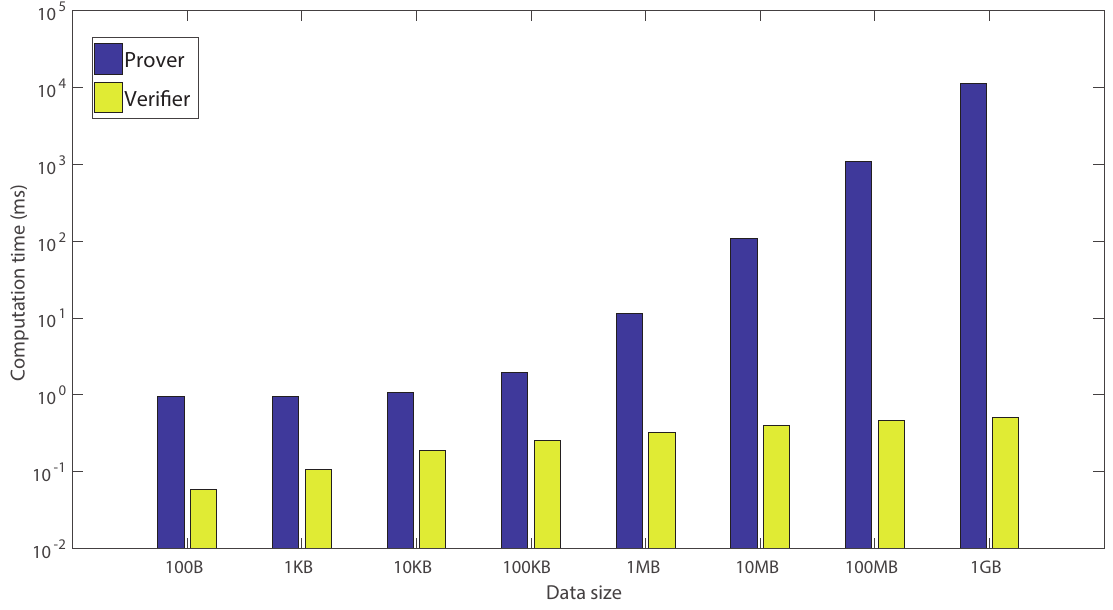
Figure 8. Computation time of the proposed authentication